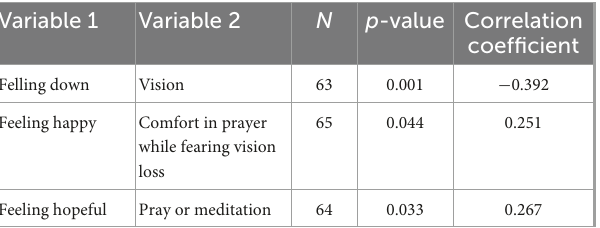
TABLE 10 The results of Spearman’s correlation for the international group.